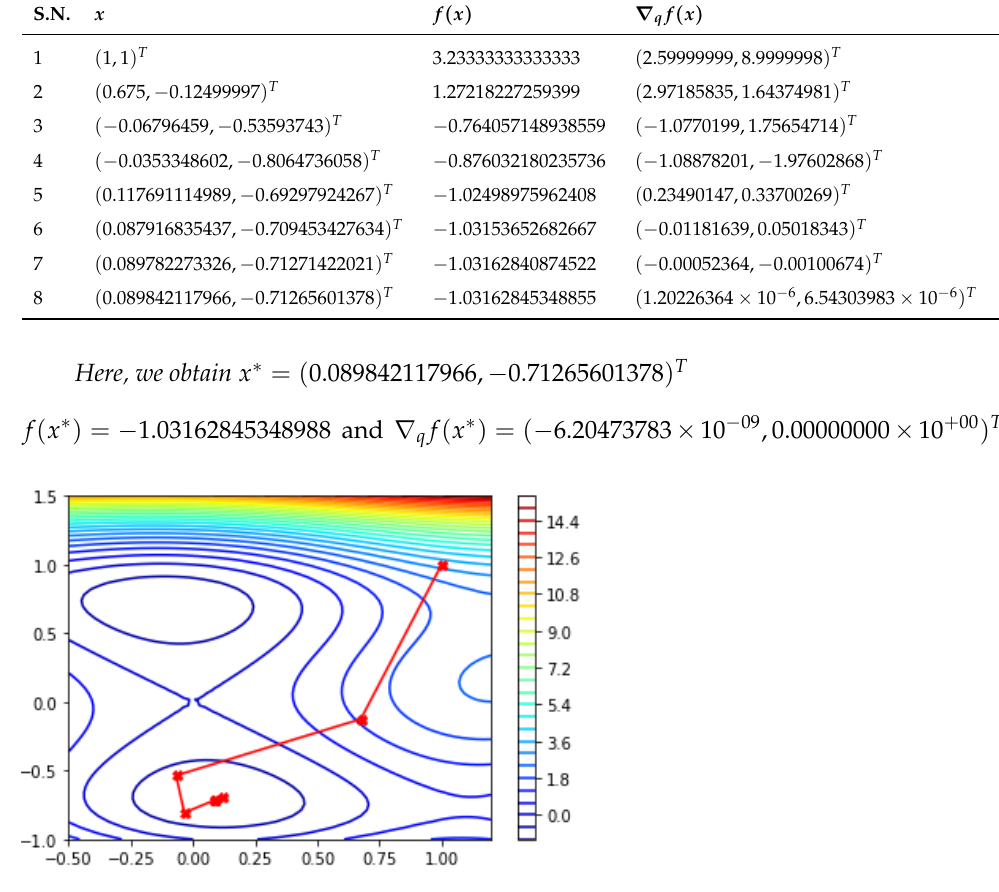
Figure 13. Global minima of SIX-HUMP CAMEL function using modified q -BFGS algorithm. Table 3. Numerical results for q -BFGS algorithm